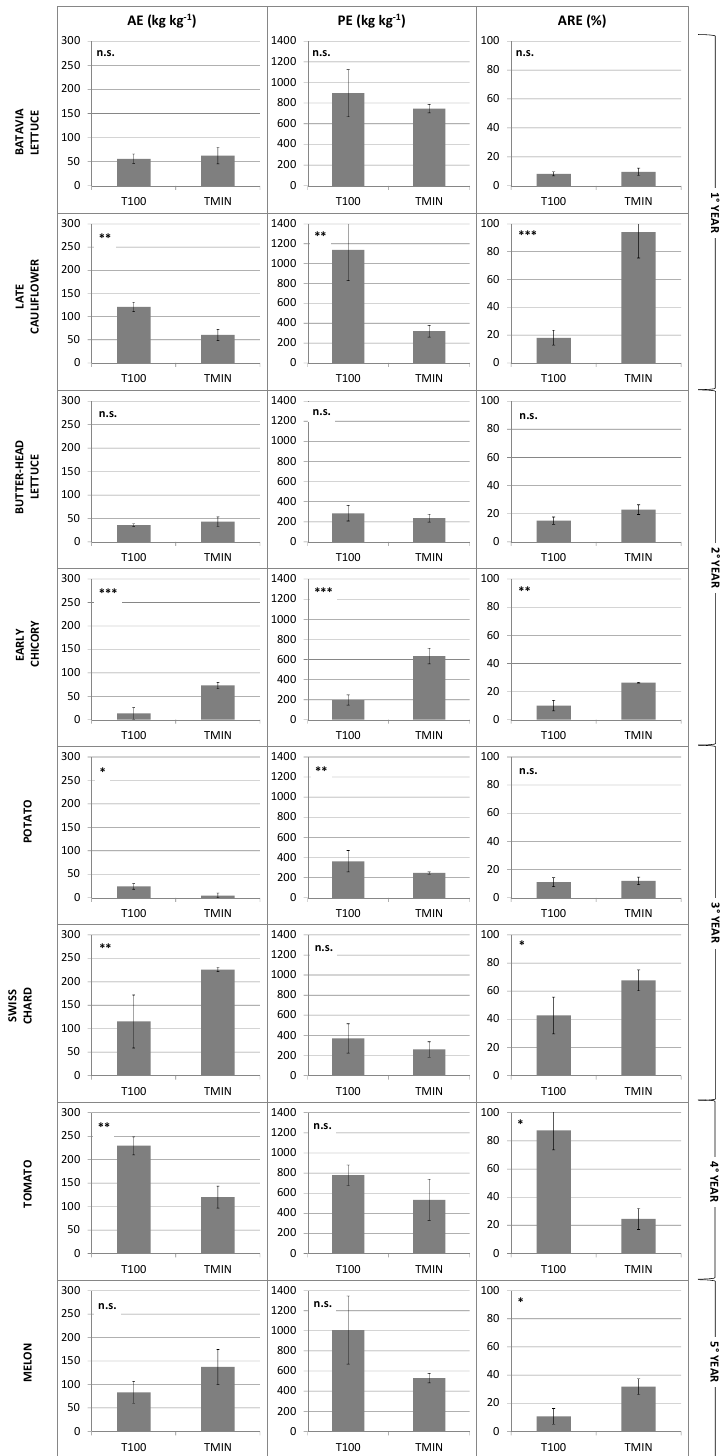
Figure 5. Nitrogen use efficiency indexes within the S1 crop succession. (AE: Agronomic efficiency; PE: Physiological efficiency; ARE: Apparent recovery efficiency). n.s.: Not significant; *: Significant p < 0.05; **: Significant p < 0.01; *** significant p < 0.001. T100: 100% N through DADRs; TMIN: Mineral control.